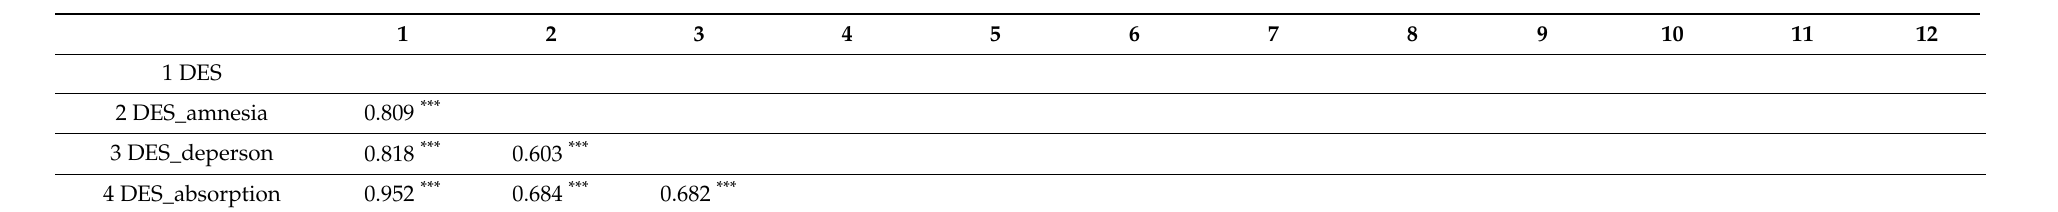
Table 5. Correlation matrix for the Hungarian